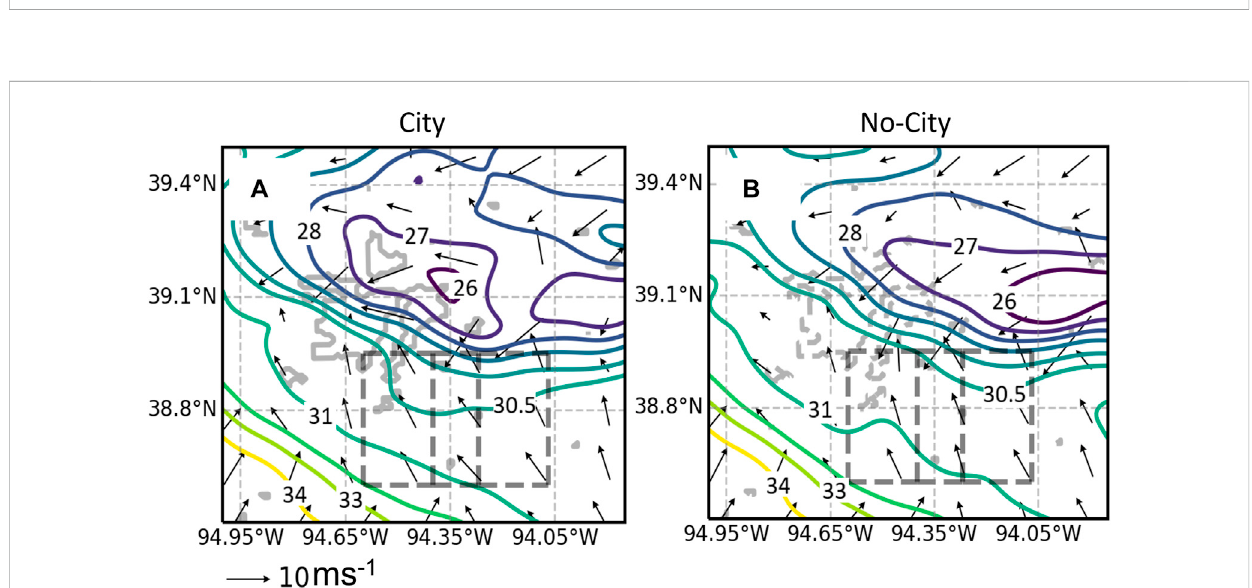
FIGURE 7 Temperature (contoured line) and wind vectors (arrow) 23:30 UTC at 100 m AGL for (A) City and (B) No-City